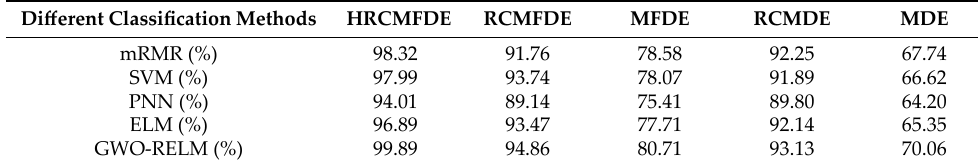
Table 15. Comparison of different models.